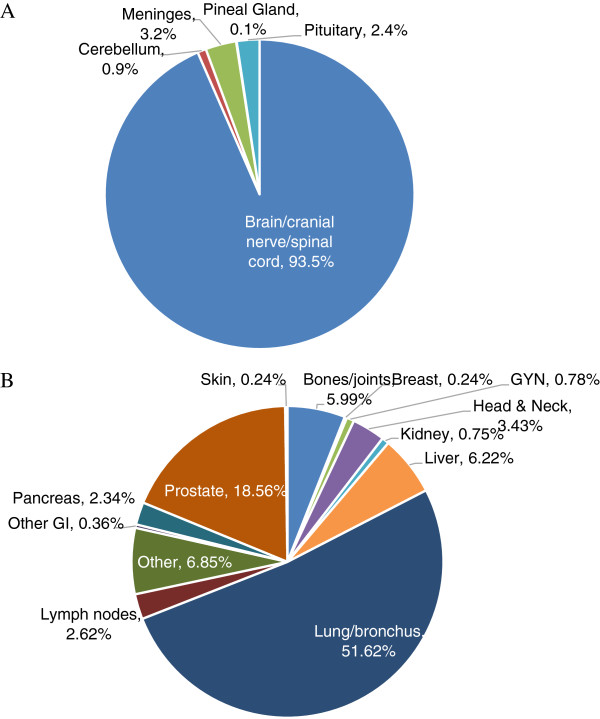
Location and percentage of intracranial lesions (A) and extracranial lesions (B) treated with SRS/SBRT.